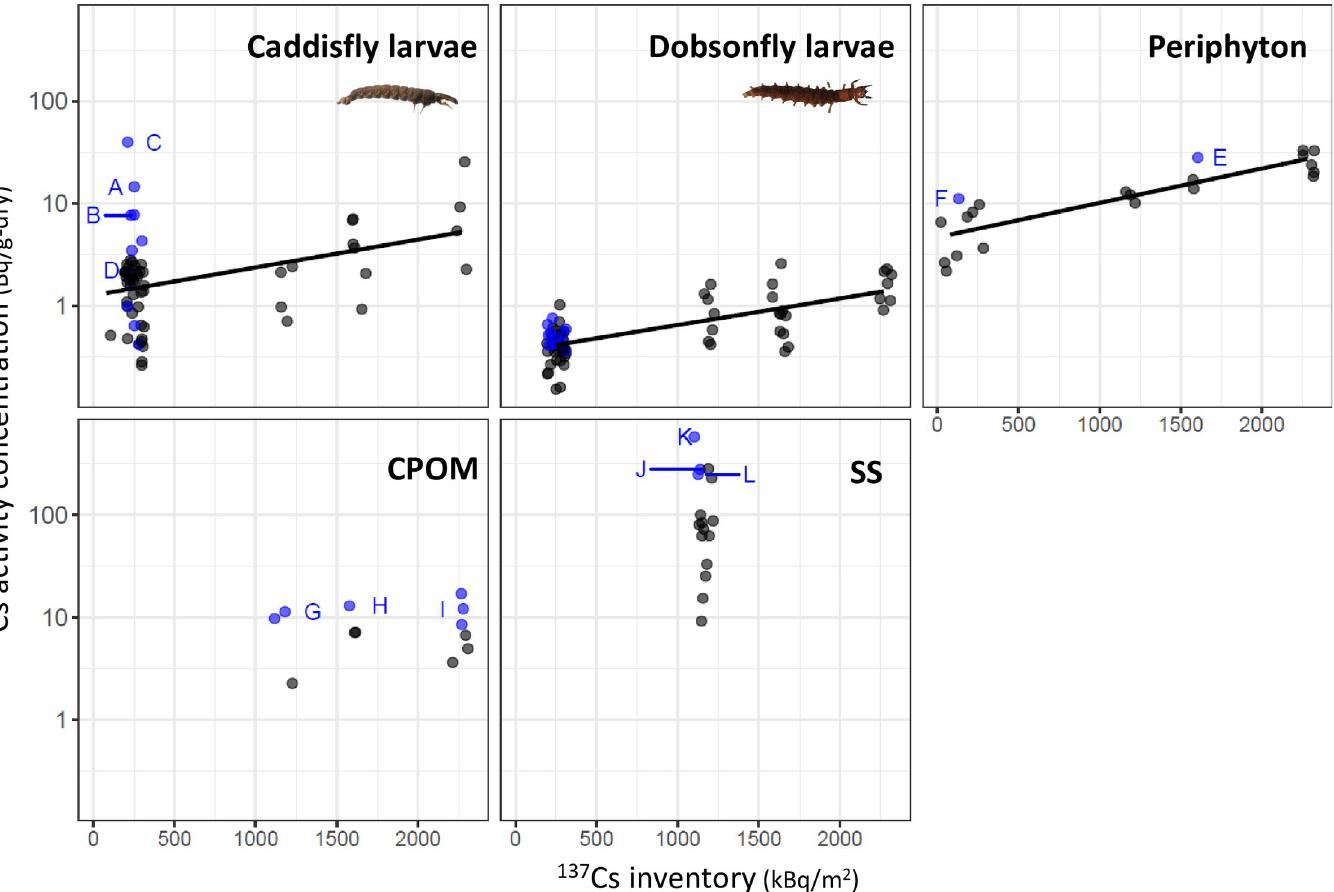
Fig 2. The 137 Cs activity concentration in aquatic insects, periphyton, coarse particulate organic matter (CPOM), and suspended solids (SS) samples. The points are jittered in the x-axis to avoid overplotting. Blue dots indicate samples provided for autoradiography, and alphabets A to L indicate the samples where CsMPs were observed (see Table 2). The lines represent linear model prediction (S1 Table). 137 Cs activity concentration of SS have been reported in Tsuji et al.